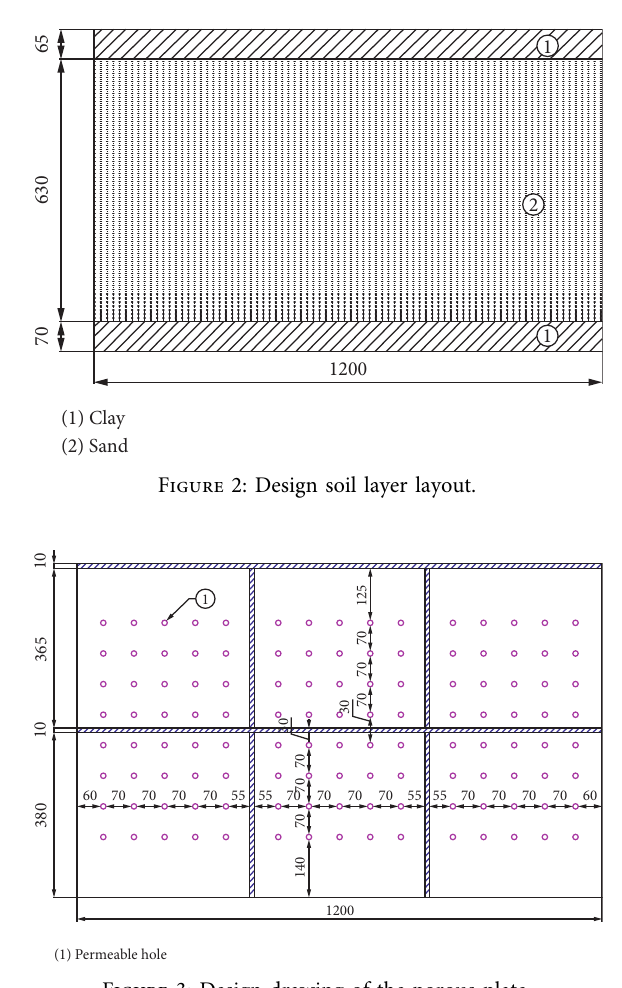
Figure 3: Design drawing of the porous plate.